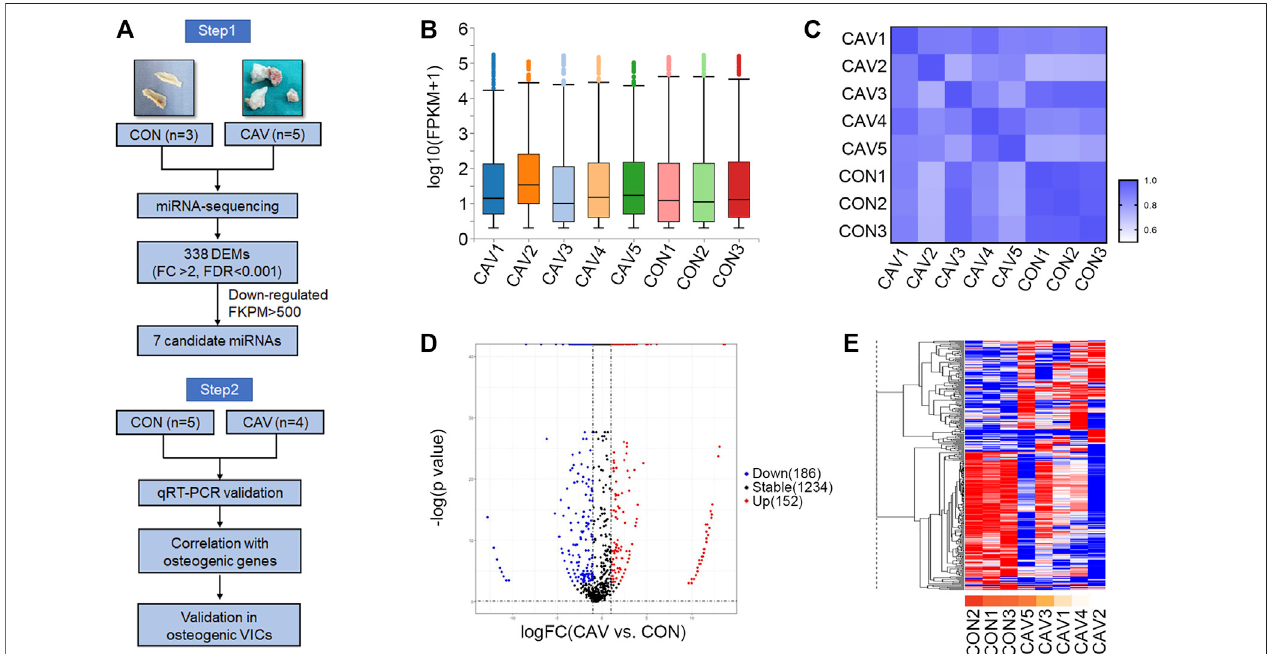
FIGURE 1 | miRNA expression pro fi le was altered during aortic valve calci fi cation. (A) Schematic description of the work fl ow illustrating the two-stage-approach involving independent samples for discovery and validation. (B) Overall count distribution of miRNAs in each sample in the RNA-sequencing experiment. (C) Pearson correlation coef fi cient of overall miRNA expression levels between every two samples. (D) Volcano plot revealing miRNA-sequencing results comparing CON ( n (cid:2) 3 biologicallyindependentsamples)versusCAV(n (cid:2) 5biologicallyindependentsamples).IndividualmiRNAsaredisplayedbythe p -valueandthecorrespondingfold change. (E) Heatmap of the 338 differentially expressed miRNAs. Red color indicated higher expression level; blue color indicated lower expression level. CON, control; CAV, calci fi ed aortic valves.